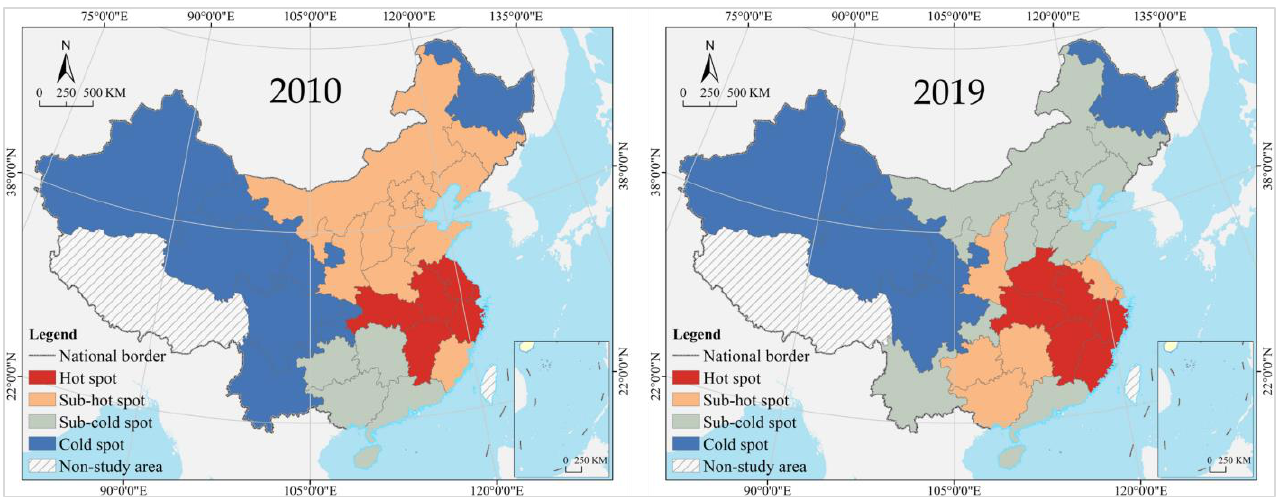
Figure 9. Spatial cluster of ECI in 2010 and 2019.